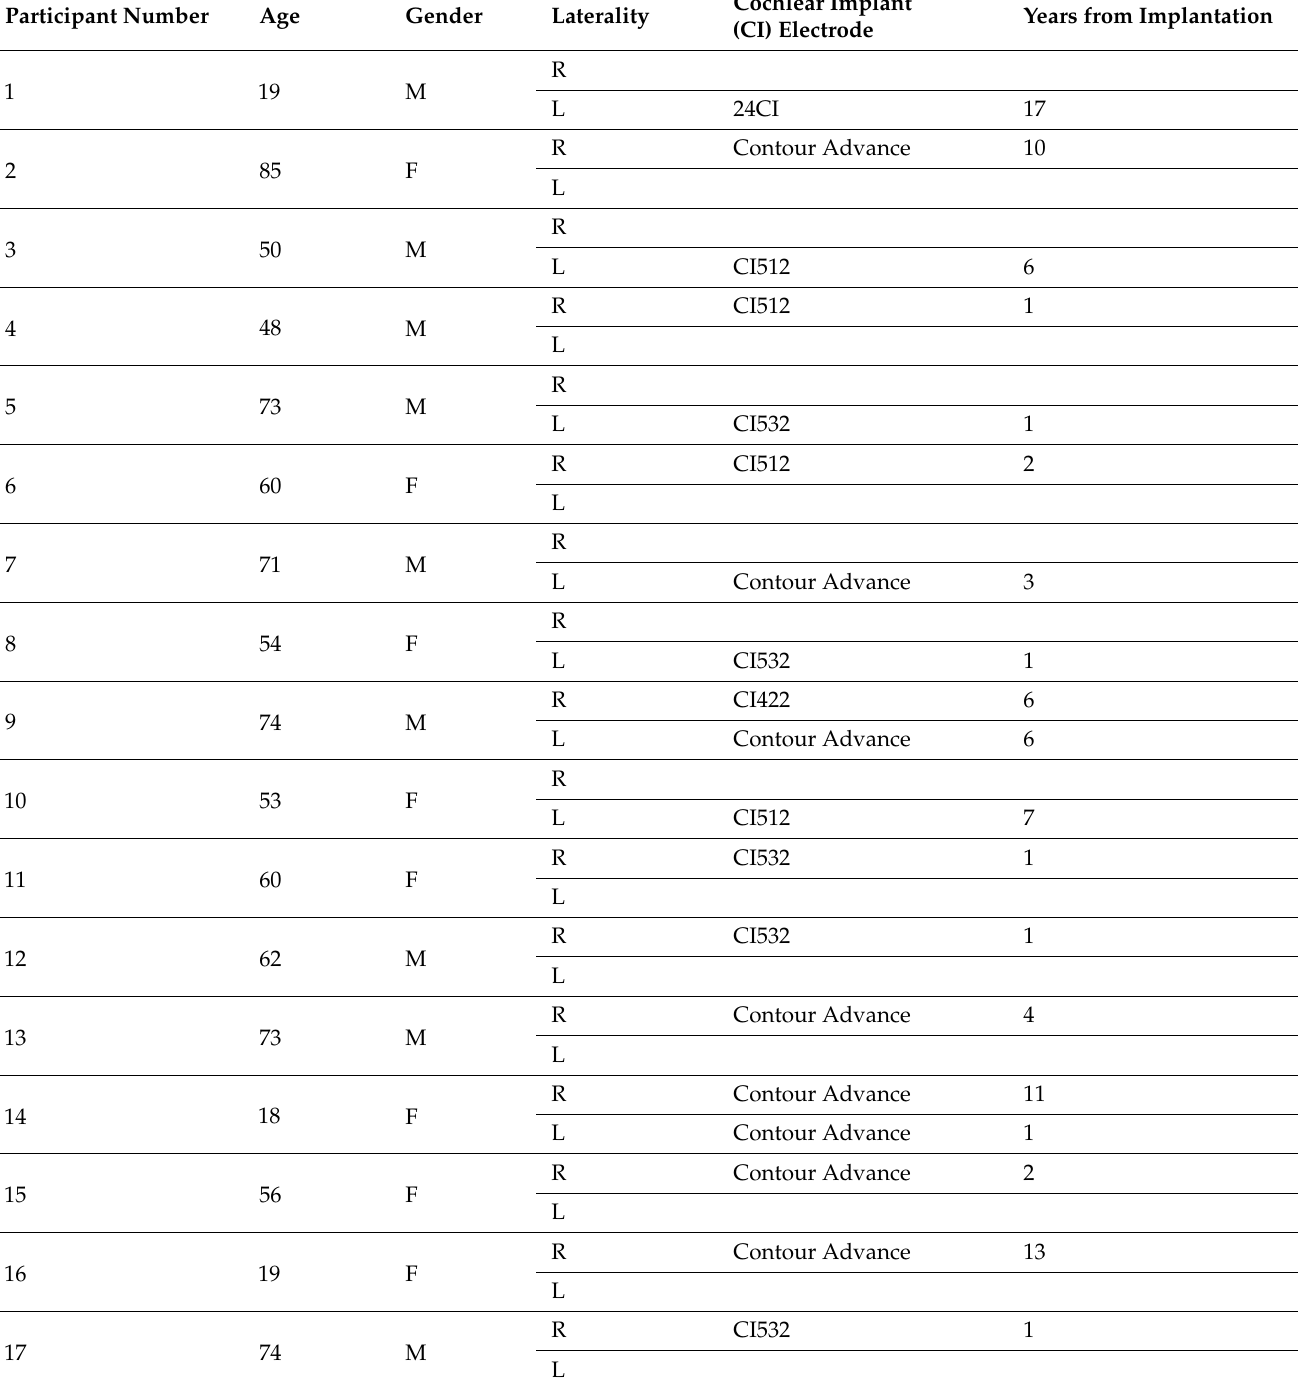
Table 1. Demographic data for the study participants with impaired